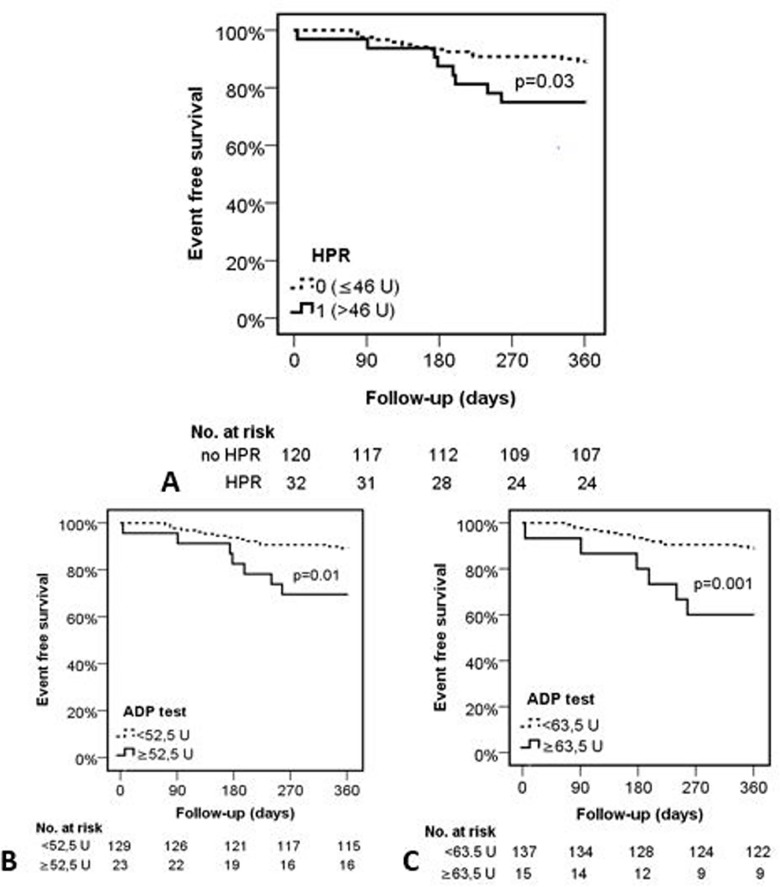
Event free survival of the patients based on the platelet reactivity during the follow up period.A: Event free survival of the patients with and without HPR based on the consensus cut-off value. B, C: Event free survival of the patients based on the ROC curve analysis identified two potential cut-off values. Event rates at one year are shown for each group as Kaplan-Meier estimates. HPR = high platelet reactivity; ADP = adenosine diphosphate.